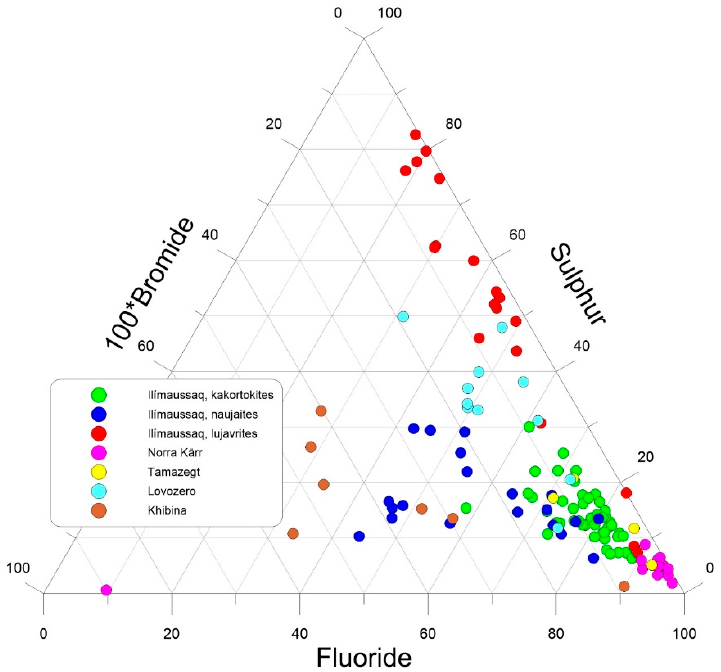
Figure 8. Ternary F-S-Br for EGM from five peralkaline intrusions illustrating clear di ff erences in halogen and sulfur systematics.